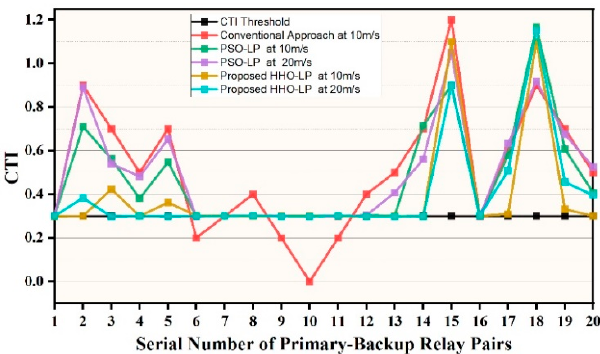
m/s and an angle variation of 10° using conventional settings and those updated with PSO–LP and 20 m / s and an angle variation of 10 ◦ using conventional settings and those updated with PSO–LP Appl. Sci. 2020 , 10 , x FOR PEER REVIEW 17 of 26 HHO–LP. and HHO–LP.